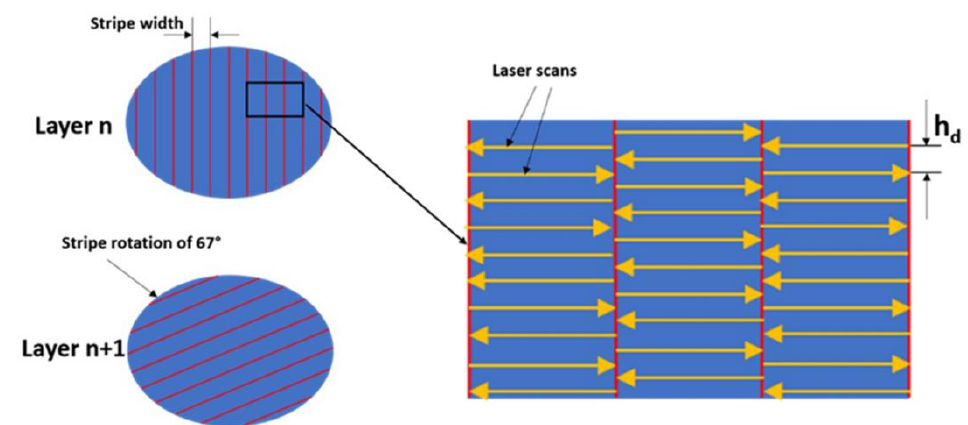
Figure 2. Schematic illustration of the scanning strategy applied in the process optimization of IN939 alloy processed by laser powder bed fusion (LPBF) .